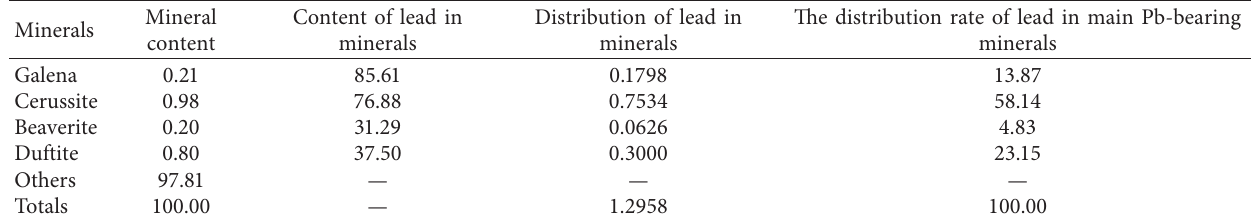
Table 9: Distribution of lead in main Pb-bearing minerals